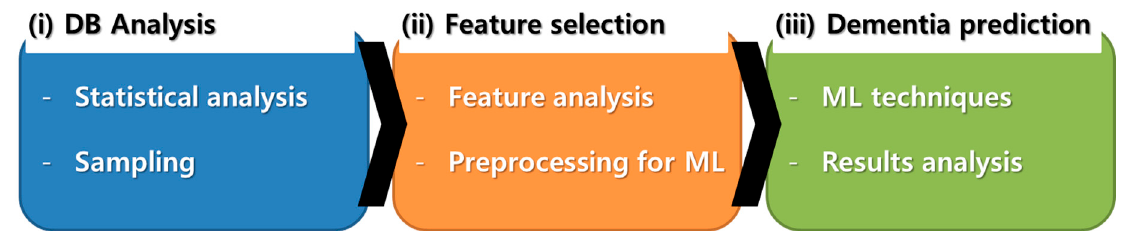
Figure 1. Dementia prediction process. DB, database; ML, machine learning.